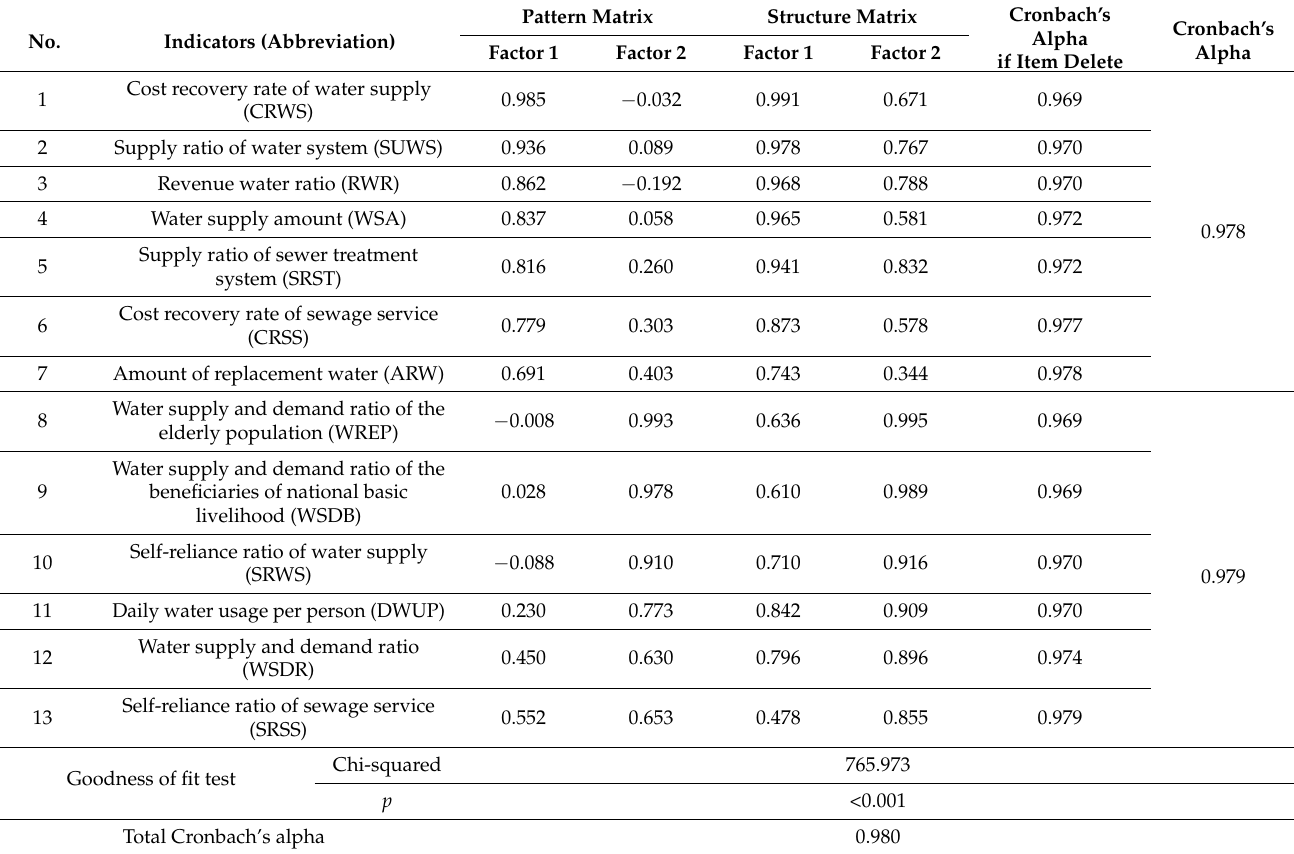
Table 8. Result of factor